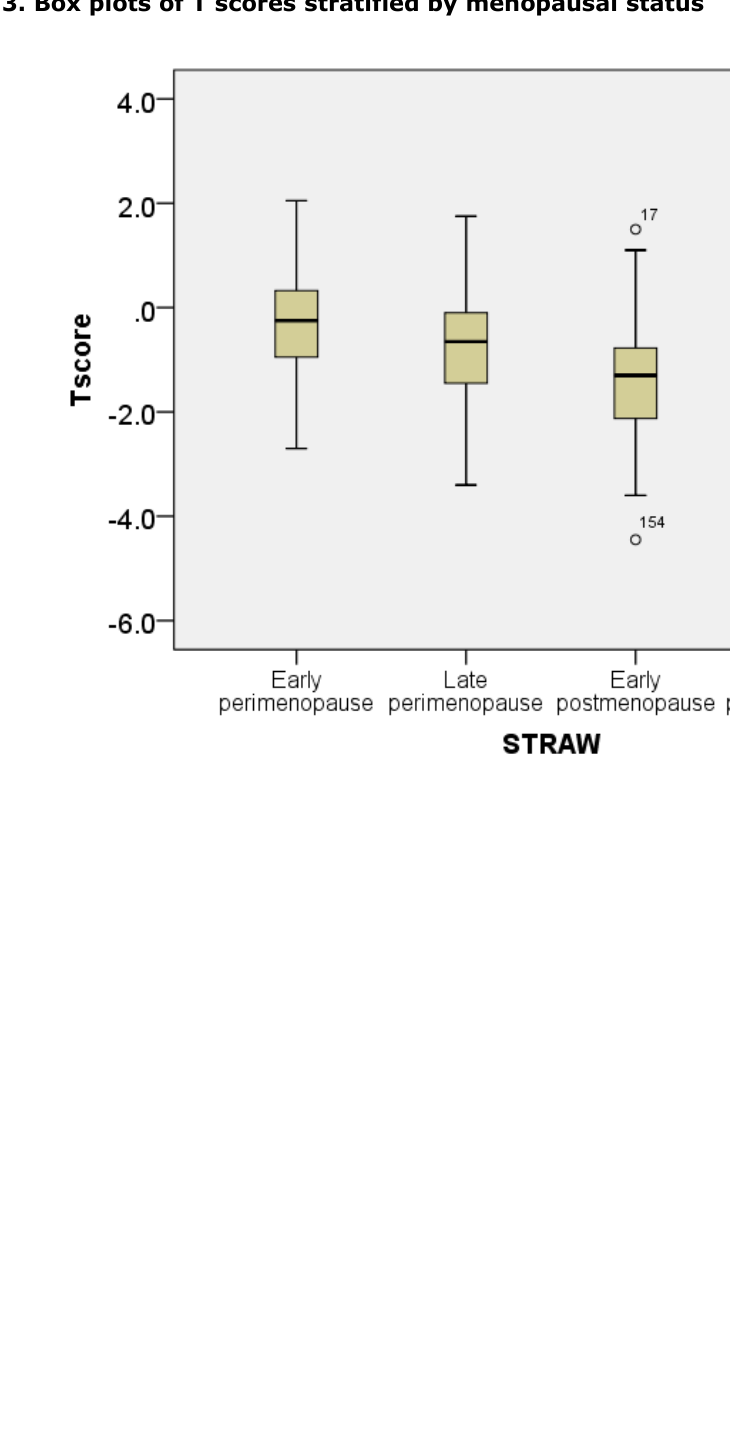
Figure 3. Box plots of T scores stratified by menopausal